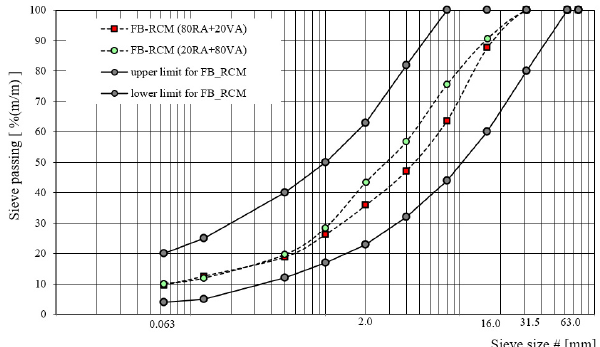
Figure 4. Gradation curve for FB-RCM with RA.